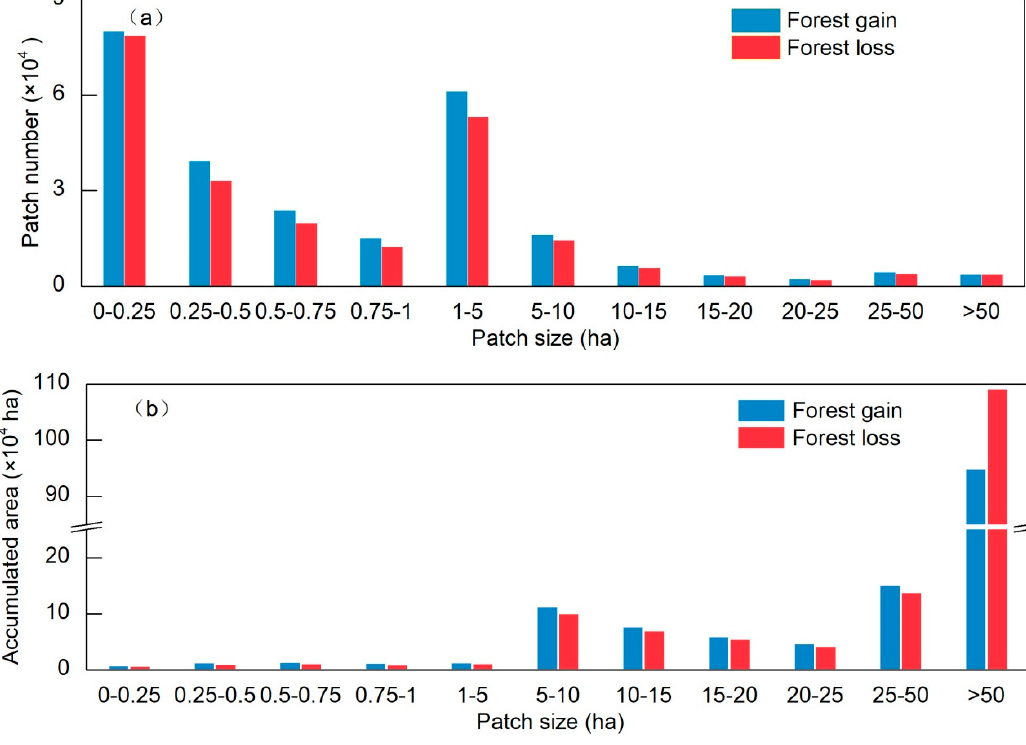
Figure 6. Patch number and accumulated area of forest changes at different patch size levels. ( a ) Patch number distribution, and ( b ) accumulated area distribution.